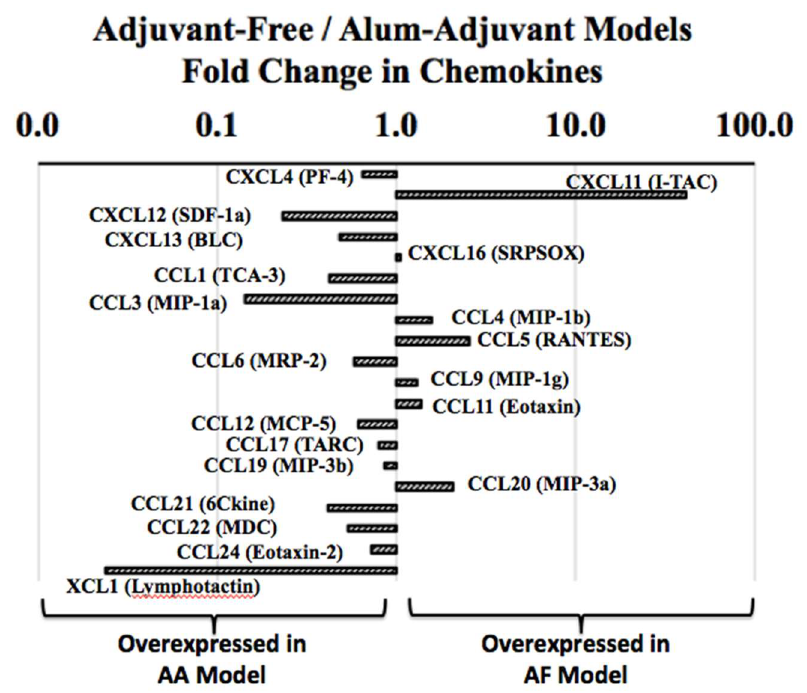
Figure 7. Analysis of in vivo activation of the chemokines in spleen tissue in the adjuvant-free vs. alum adjuvant mouse models of wheat allergy. Spleen tissues were collected from the experimental groups of mice in the AF vs. AA models, and used in the chemokine protein analysis, as described in the methods. Using the pg/mg spleen protein content, fold changes in chemokines in the AF vs. AA models were determined as shown. Data shows that different sets of chemokines are overexpressed in vivo in the AF vs. AA models, indicating the different mechanisms of wheat allergenicity.